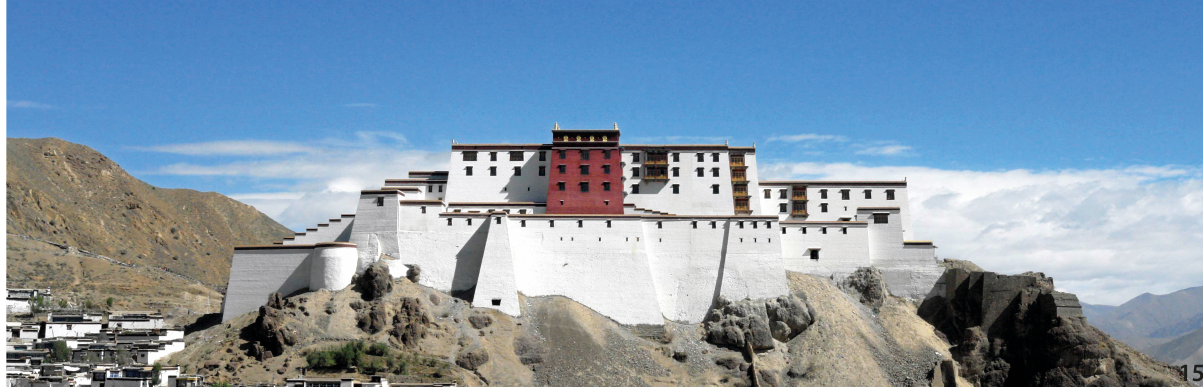
Figure 15 Sangzhutse Fortress after restoration (Source: Zhang